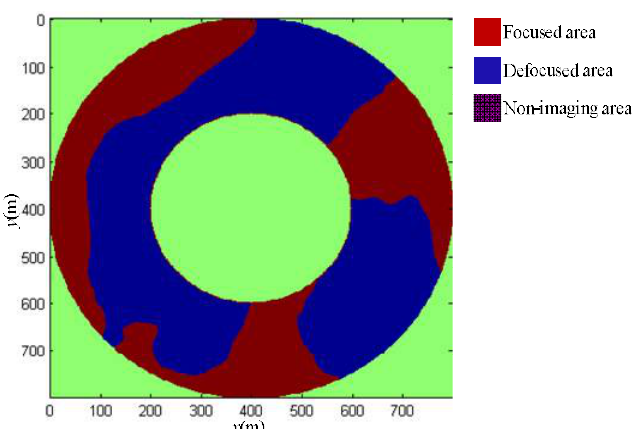
Figure 21. The defocused area and focused area of imaging result on the reference plane.